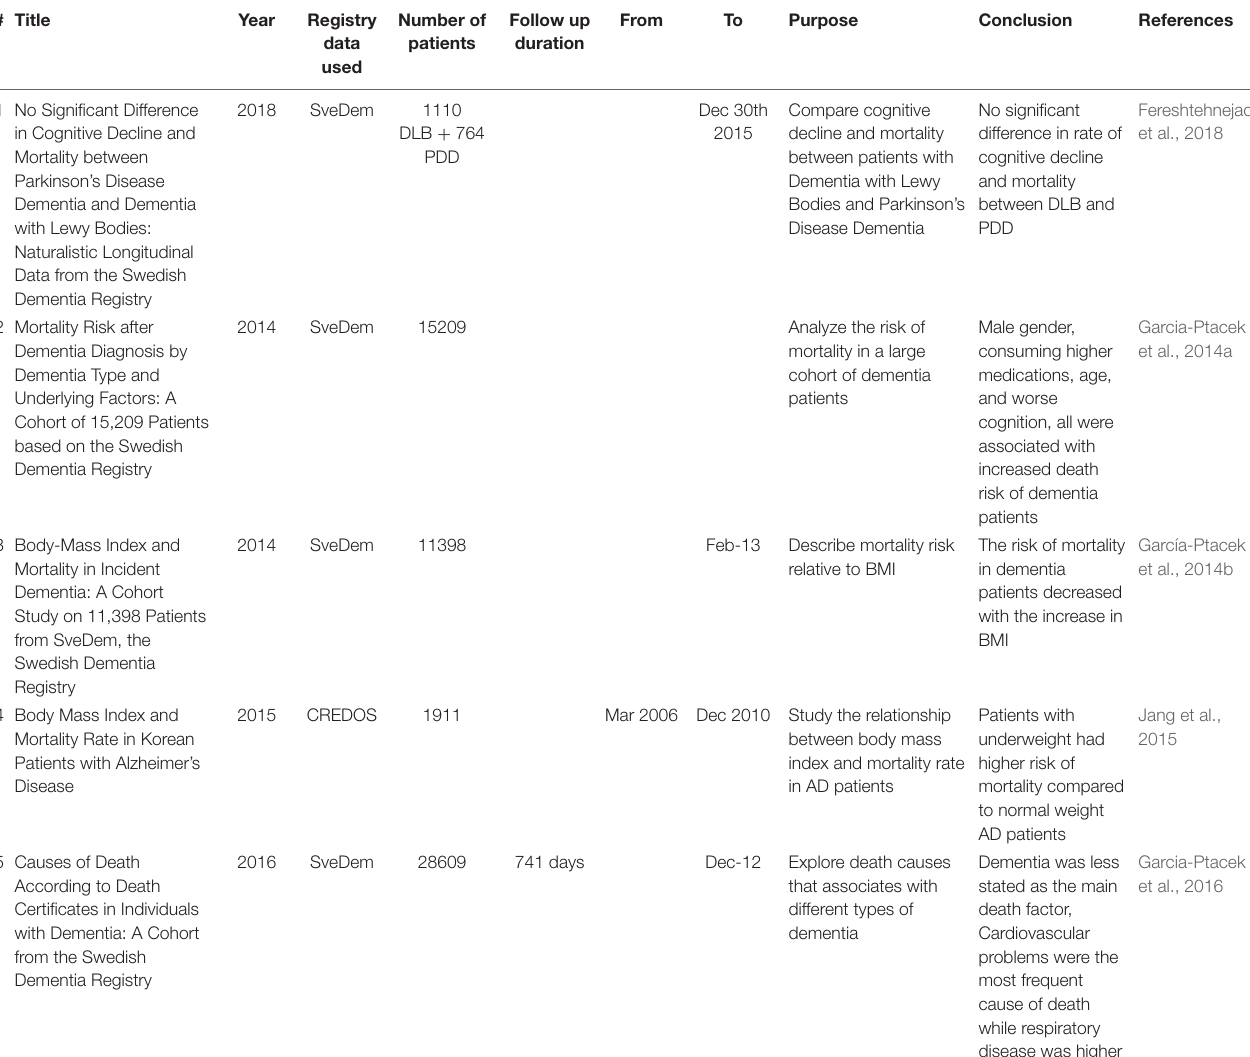
TABLE 2 | Registry-based studies on dementia mortality